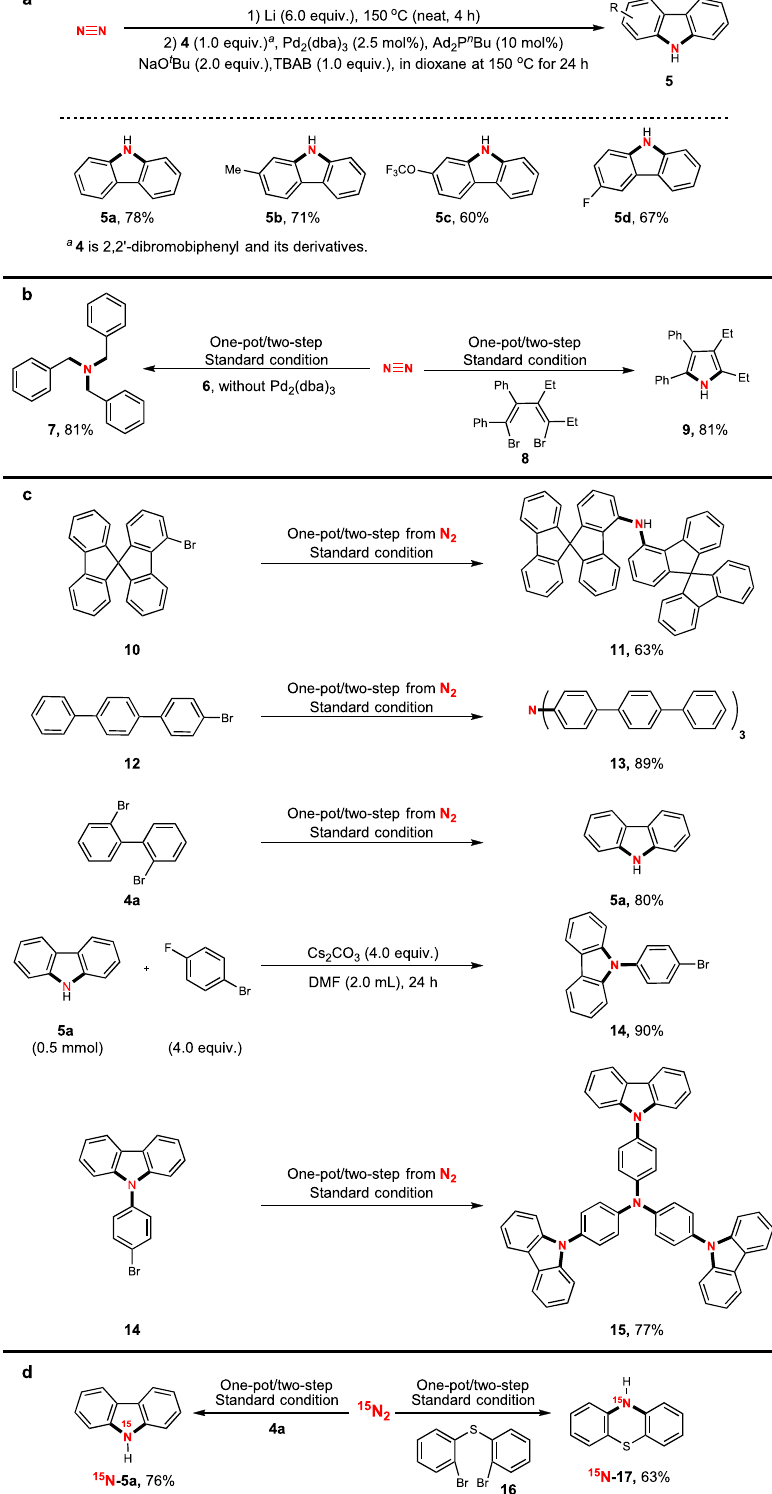
Fig. 3 Synthetic applications. a Carbazole synthesis through one-pot/two-step nitrogenation. b One-pot/two-step procedure to carry out direct nitrogenation using dinitrogen (N 2 ) to synthesize tribenzylamine and pyrroles. c Synthesis of complicated structures through direct nitrogenation using dinitrogen (N 2 ). d Synthesis of 15 N-labelling complexes through direct nitrogenation using dinitrogen ( 15 N 2 ).